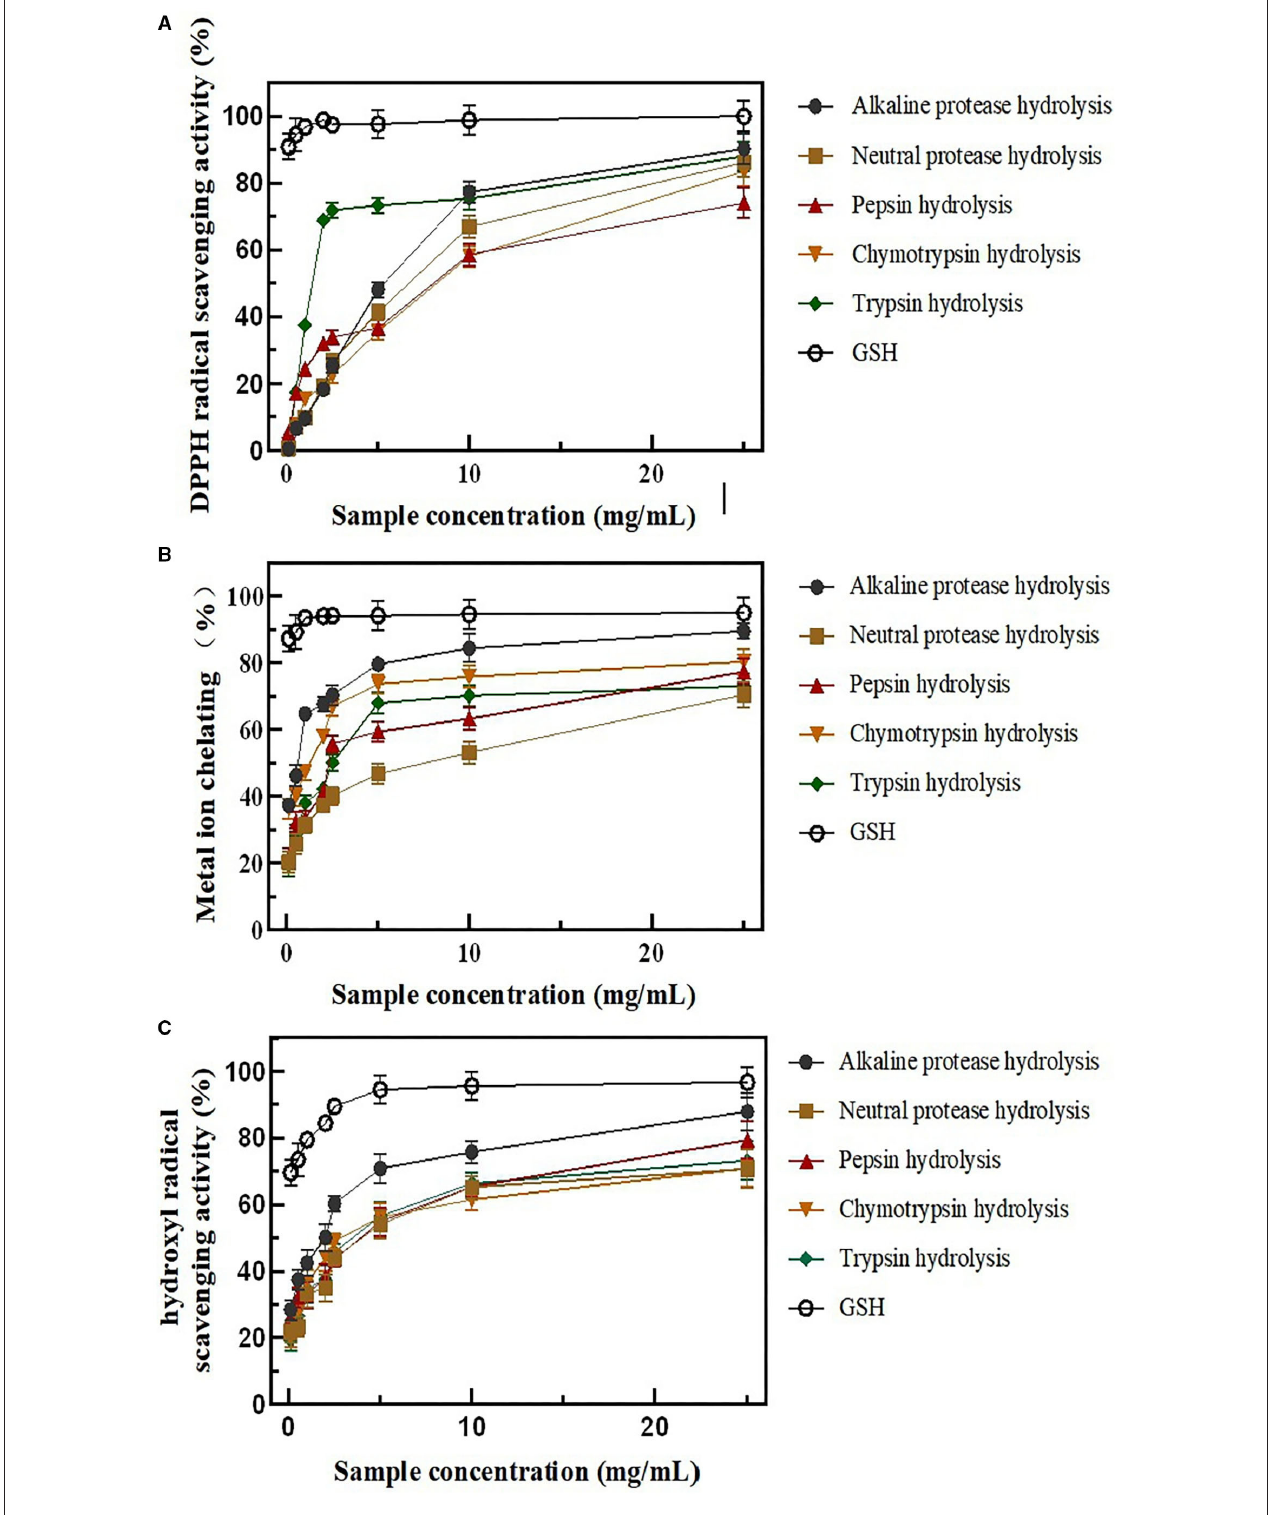
FIGURE 2 | BRPHs antioxidant capacity in vitro (A) DPPH radical scavenging activity; (B) metal ion-chelating activity; (C) hydroxyl radical scavenging activity; Data are expressed as mean ± SD, n = 3. BRPHs, BRPH, broken rice protein hydrolysate; DPPH, 1,1-diphenyl-2-picrylhydrazyl.